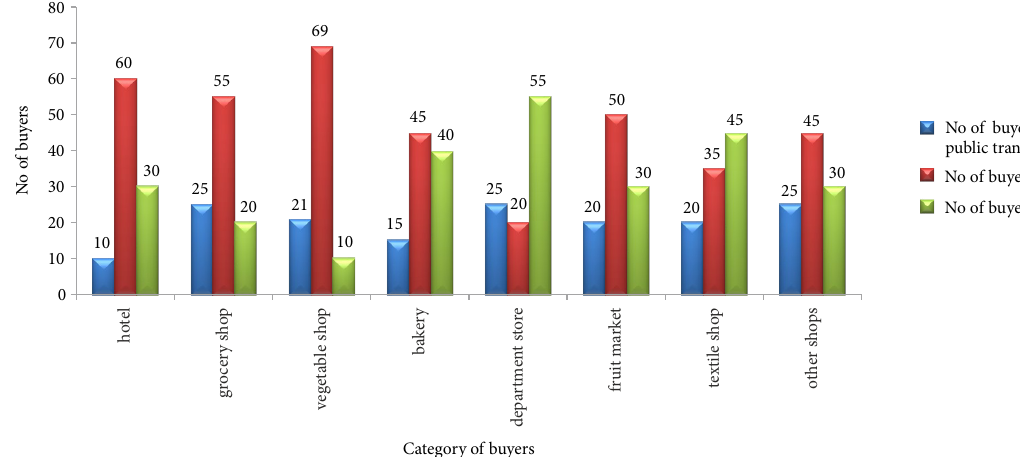
Figure 1. VEKIT research survey showing the percentage of buyers using different